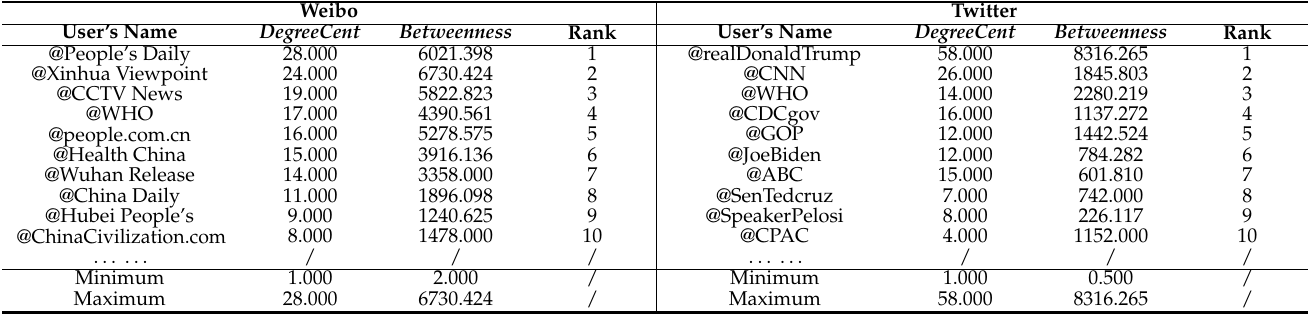
Table 4. Network centrality measurements on Twitter and